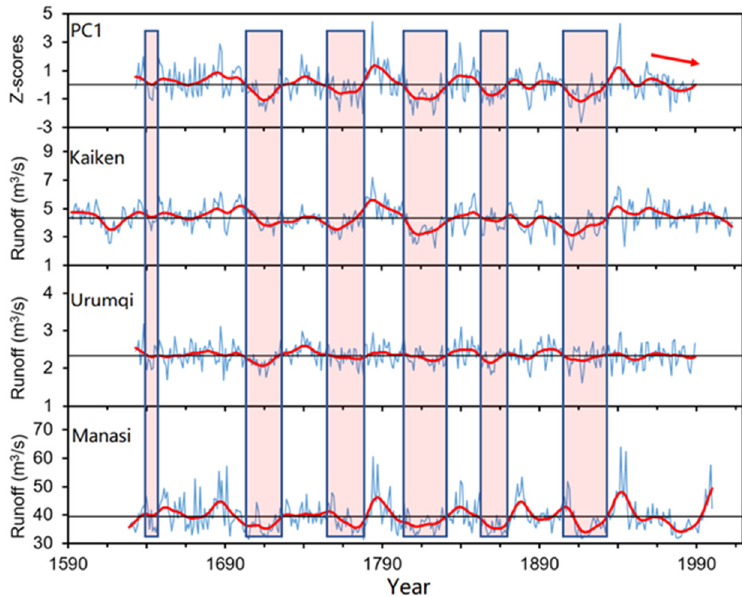
Figure 6. The first principal component (PC1) of the runoff reconstructions of Kaiken, Urimqi and Manasi rivers. Graphical comparison of various runoff reconstructions for Kaiken, Urimqi and Manasi rivers derived from tree rings. All runoff reconstructions were smoothed with a 21-year low-pass filter to emphasize long-term fluctuations.